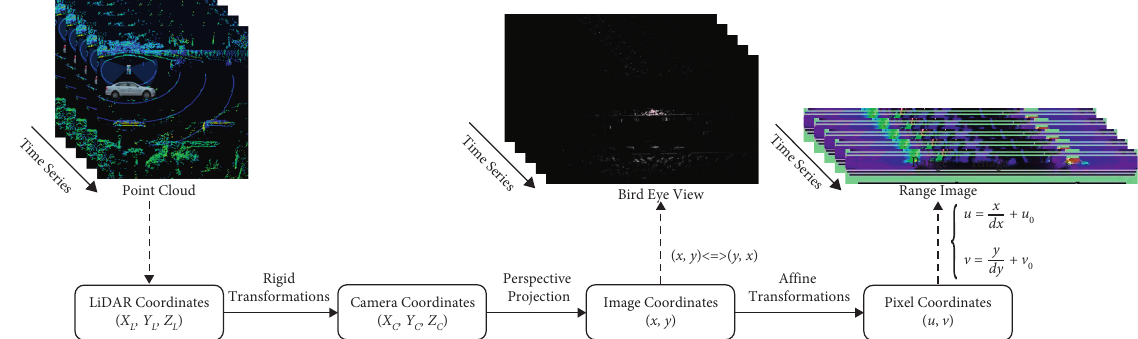
Figure 2: The multiview point cloud generation